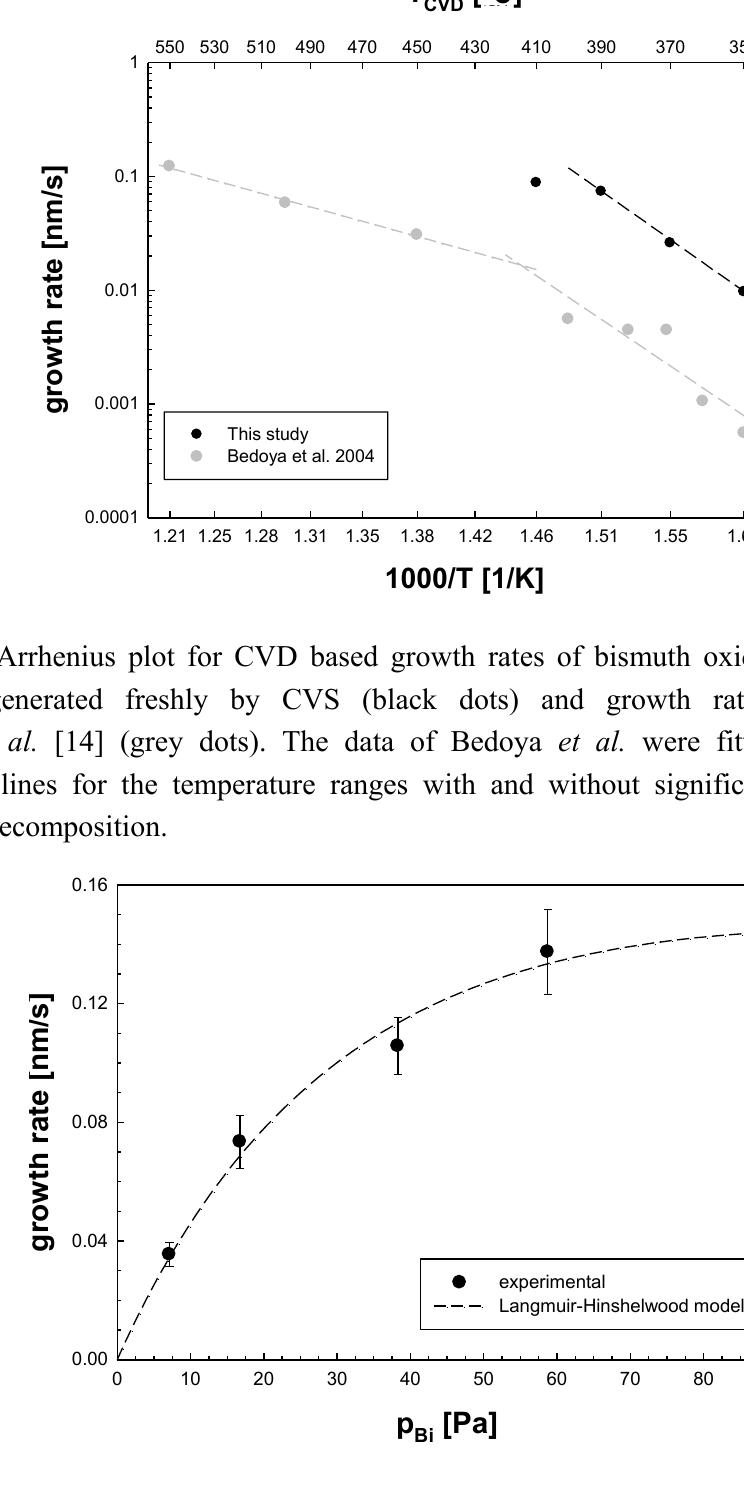
Figure 5. CVD based film growth rates vs. partial pressure of the bismuth precursor. Data for bismuth oxide on silica particles generated freshly by CVS, fit function for Langmuir-Hinshelwood growth